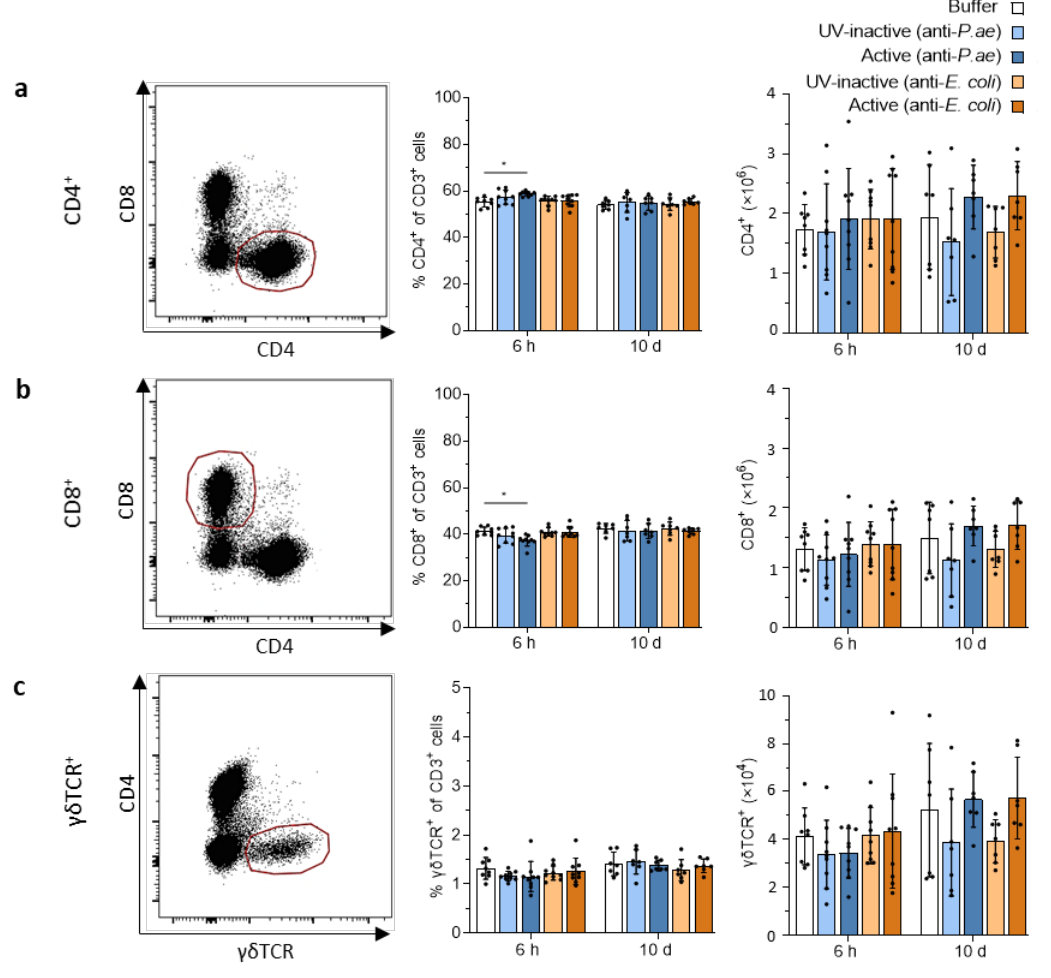
Figure 5. T cell populations in the draining lymph nodes show no marked changes after phage treatment. Analysis of ( a ) CD4 + , ( b ) CD8 + and ( c ) γδ TCR + T cells in the lymph nodes. Shown are representative dot plots (left) and bar graphs depicting the percentage of remaining cells (middle) or total cells (right). Results are shown as mean ± SD, as determined by 2-way ANOVA with Tukey ’ s multiple comparisons test: * p < 0.05; n = 7 – 9 mice per group. For full gating strategy and cell type identifying markers see Figure S2.